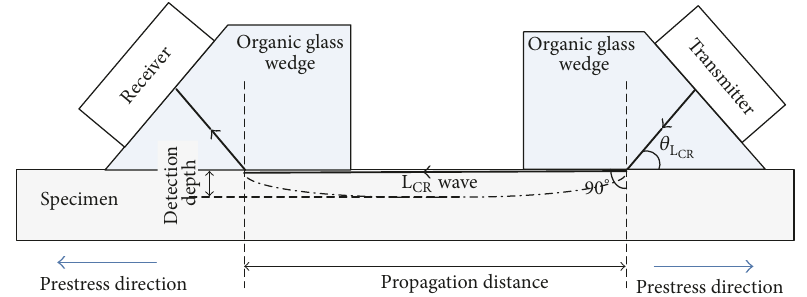
Figure 1: The mechanism of L CR wave.